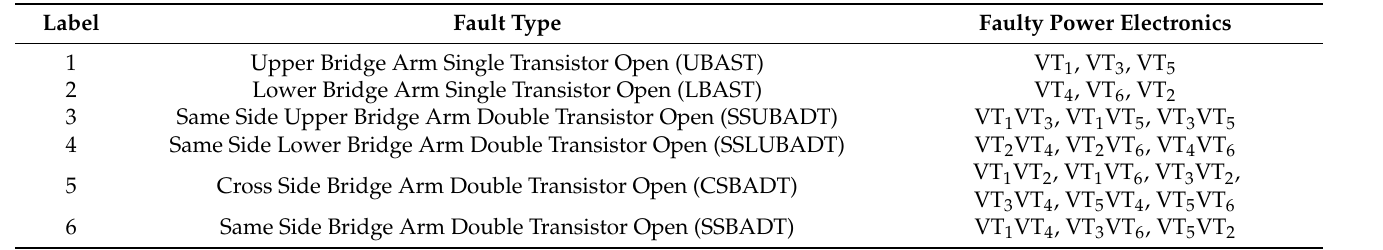
Figure 5. Phase-Current Trace of Electric Propulsion System Before and After Fault: ( a ) Normal ( b ) VT 1 Opend ( c ) VT 1 and VT 3 Opend ( d ) VT 1 and VT 6 Opend. According to these, 21 kinds of IGBT open-circuit faults are divided into six categories in Table 1 for research. Table 1. Fault classification of inverter unit in marine electric propulsion system.